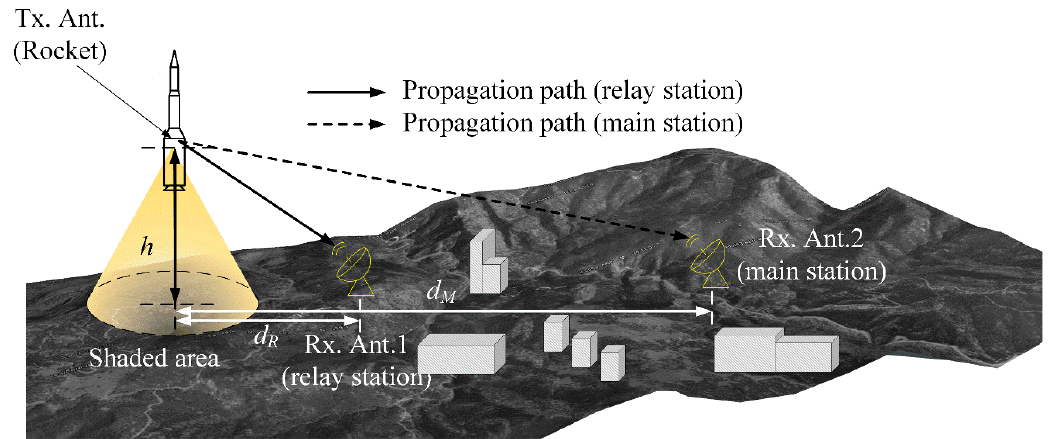
Figure 1. Configuration of the S-band telemetry system with main and relay stations.